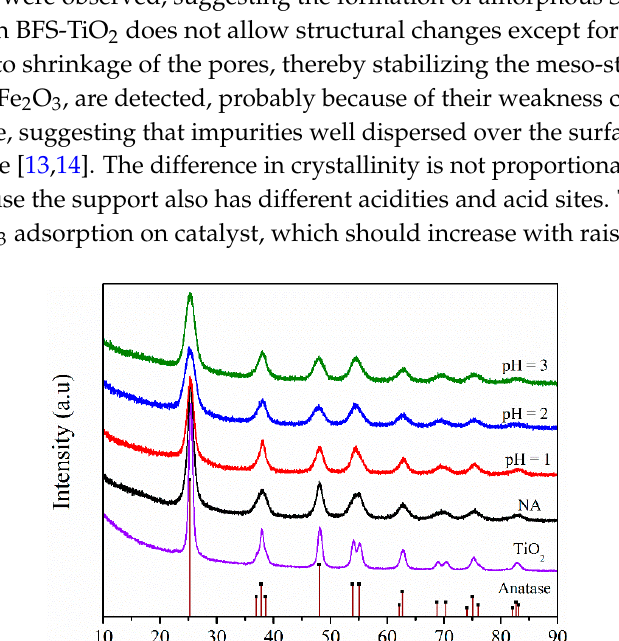
2 samples and commercial TiO 2